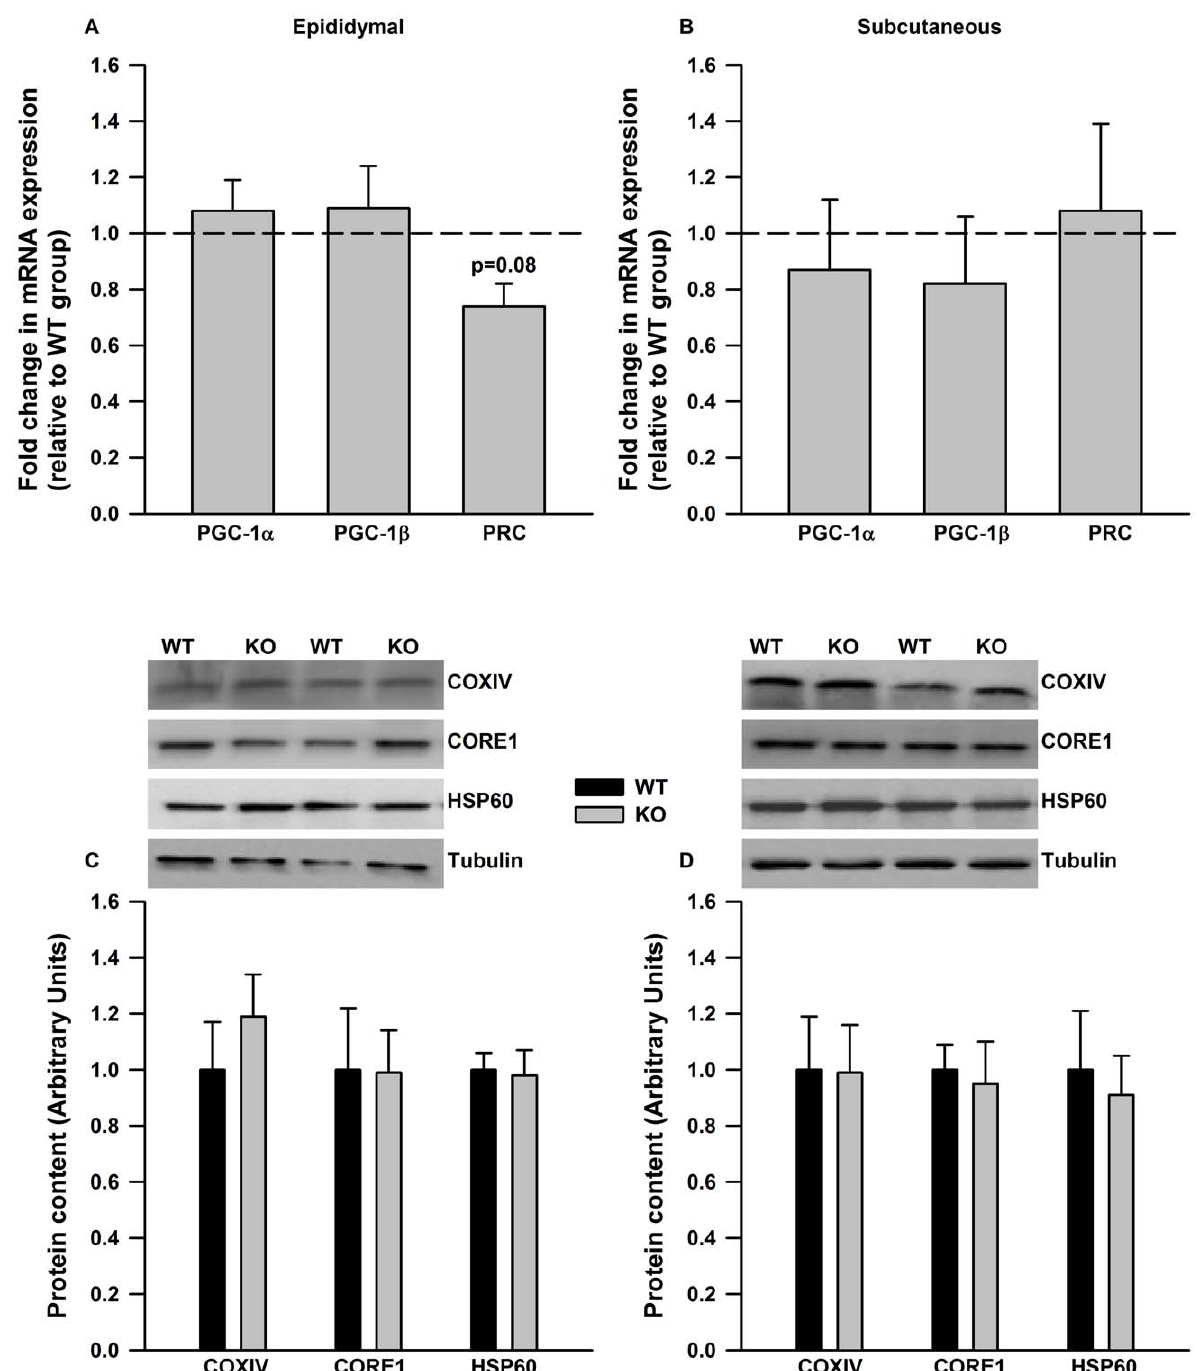
Figure 2. PGC-1 expression and mitochondrial markers proteins are not different in adipose tissue from WT and IL-6 2 / 2 mice. The mRNA expression of PGC-1 co-activators (A and B) and mitochondrial marker proteins (C and D) are not different in epididymal (A and C) and subcutaneous adipose tissue (B and D) from WT and IL-6 2 / 2 deficient mice. In A and B mRNA data is expressed relative to values in WT controls. Representative Western blots are given above the quantified data in C and D. Data are means + SE for 10 samples per group. induce PGC-1 co-activators and mitochondrial enzymes in cultured adipose tissue and examined changes in PGC-1 and markers of mitochondrial content in adipose tissue from whole body IL-6 2 / 2 mice.